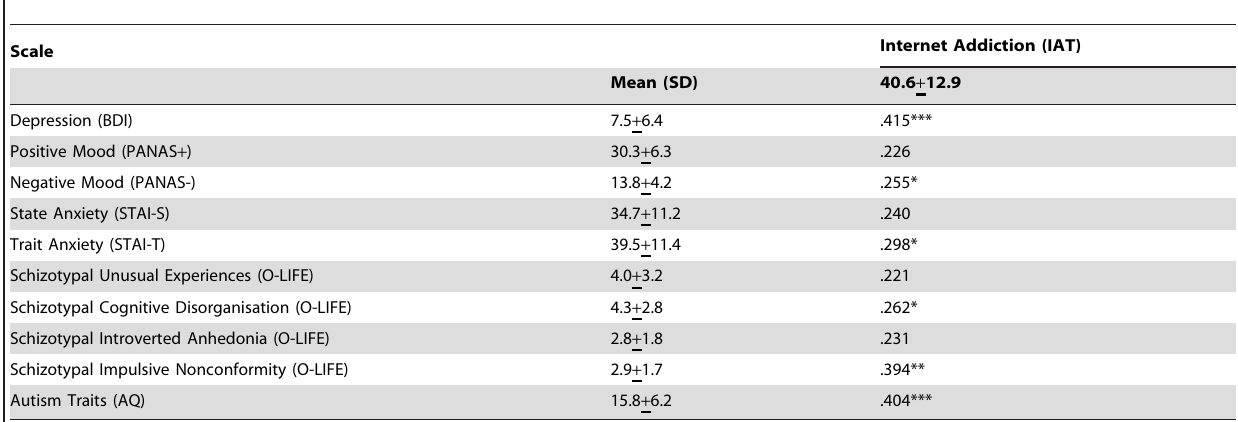
Table 1. Means (standard deviations) for all psychometric measures and their spearman correlation coefficients with internet addiction test (IAT).